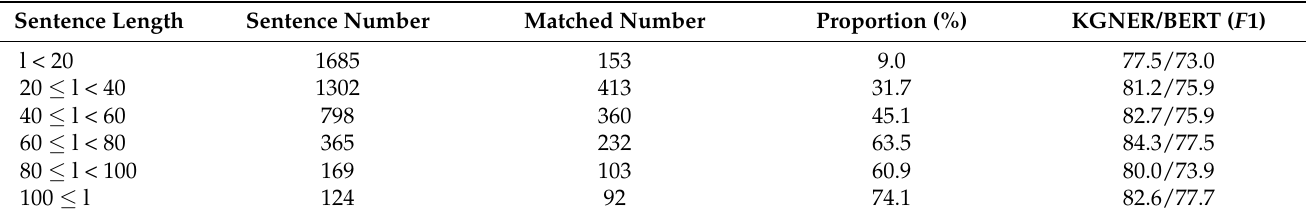
Table 5. F 1 score against sentence length on the OntoNotes